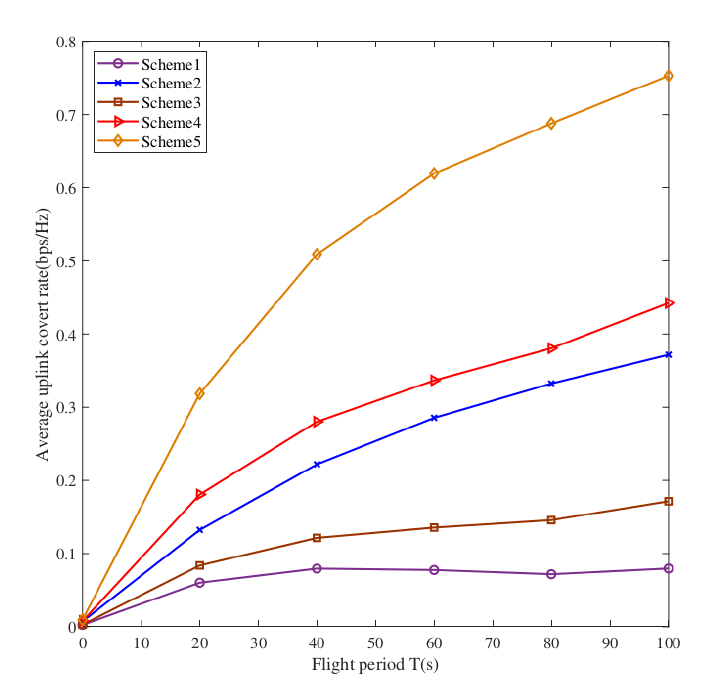
Figure 7. The average uplink covert rate for different optimization schemes.